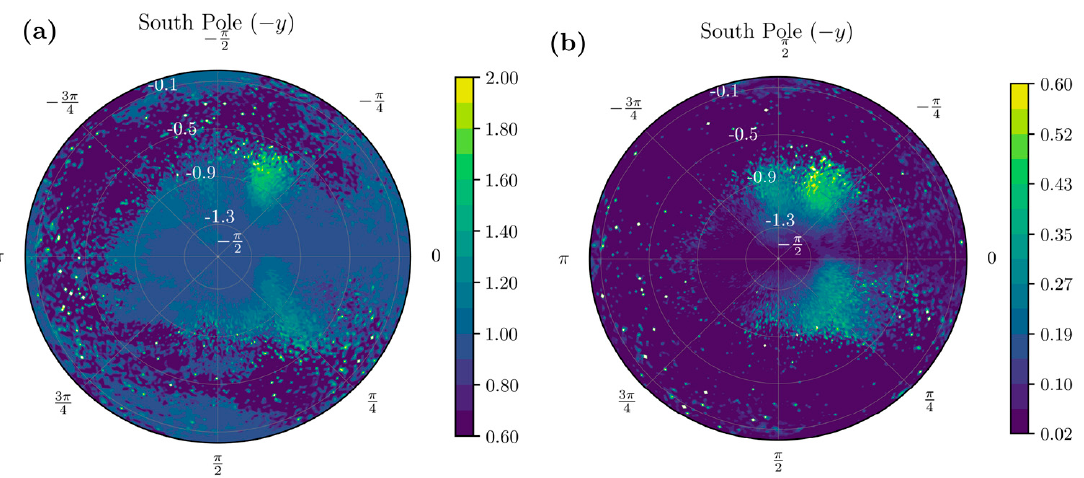
Figure 4. Visual representation of mean and standard deviation of resultant accelerations magnitude across various orientations when performing ADLs. ( a ) Distribution of means of acceleration samples for every orientation across the southern hemisphere of the UAS. Higher means indicate high-acceleration movements in that orientation. ( b ) The variability of the motion for each orientation is shown. The color bars represent the log of the probability density of the projection of the acceleration onto the UAS.